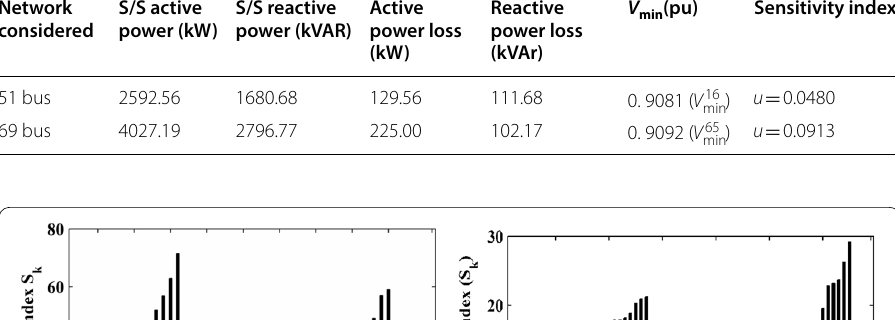
Table 1 Load flow results without DGs and shunt capacitors Network S/S active S/S reactive Active considered power (kW) power (kVAR) power loss